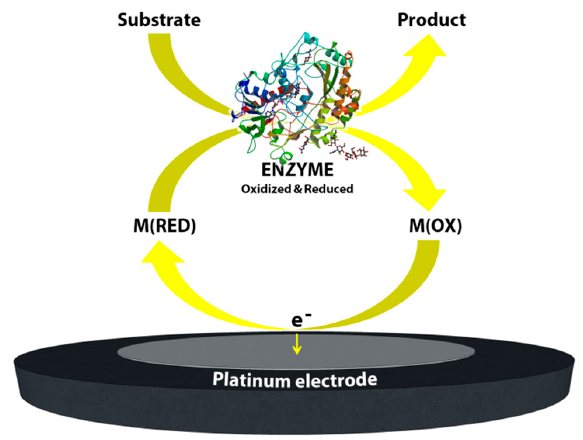
Figure 3. Schematic image of the mediated biosensor working principle, second generation biosensors.